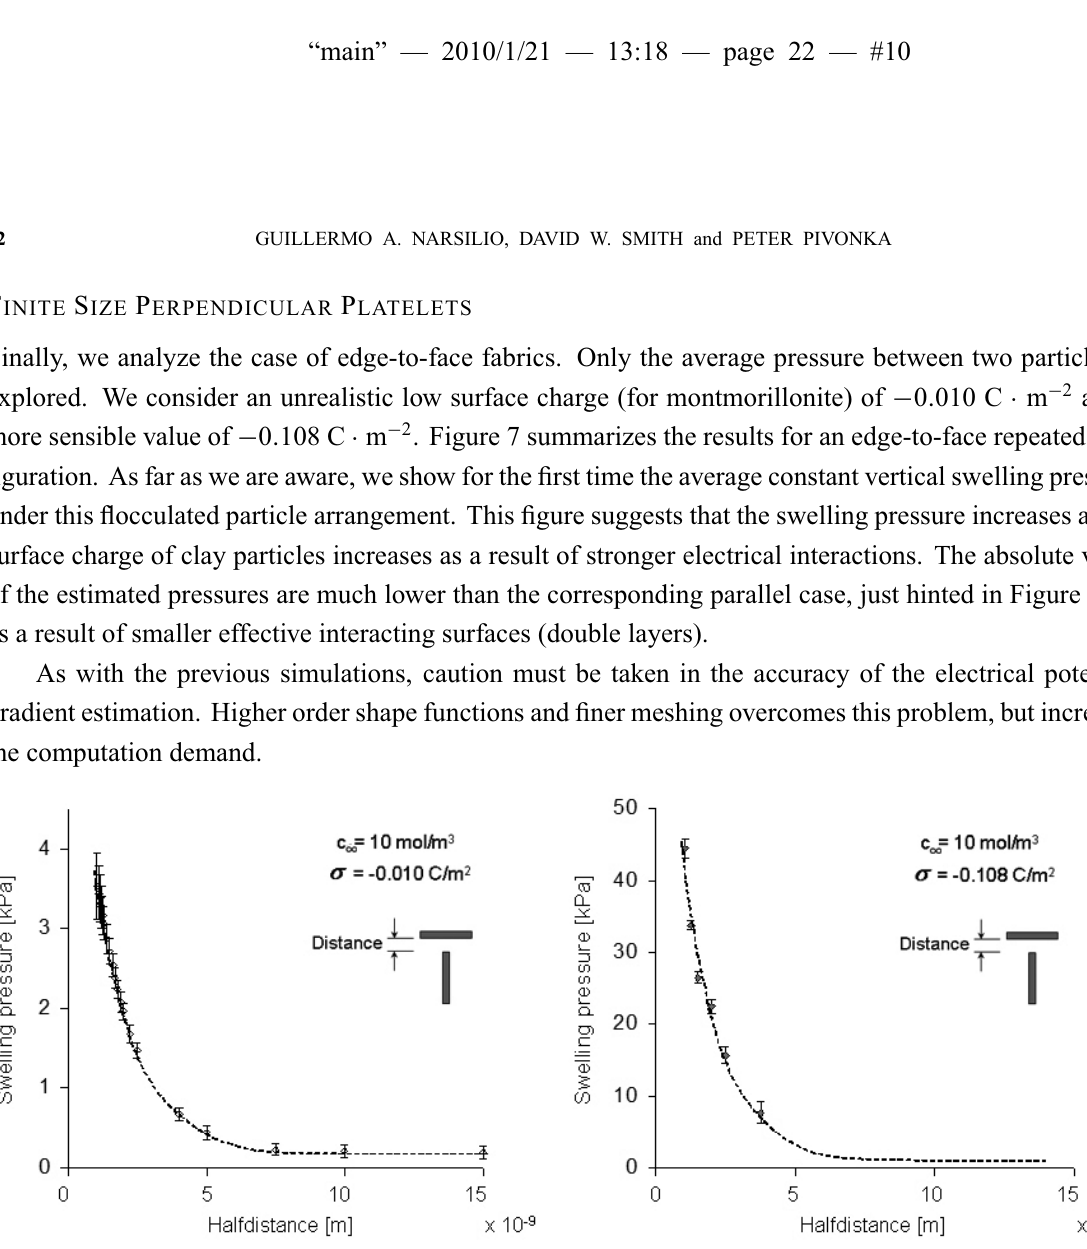
10 mol ∙ m − 3 σ = − 0 . 010 C ∙ m − 2 and − 0 . 108 C ∙ m − 2 ) ∞ =